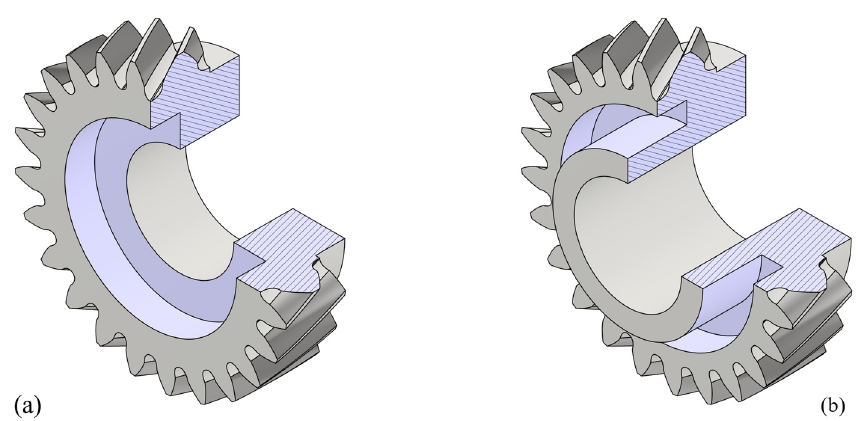
Figure 3. Examples of not-feasible gear body geometries.( a ) and ( b ) are two possible geometries with a different position and size of the sensor board.